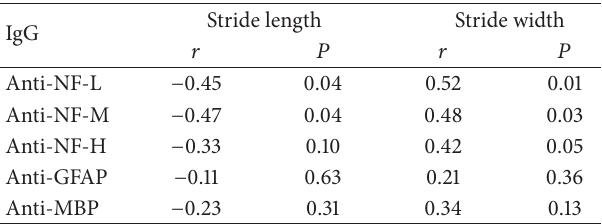
∗ Total gait measurements; 𝑛 = 21 measured gaits.